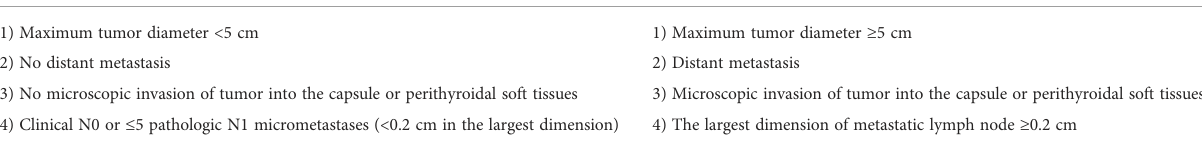
TABLE 1 Risk strati fi cation standard of the present